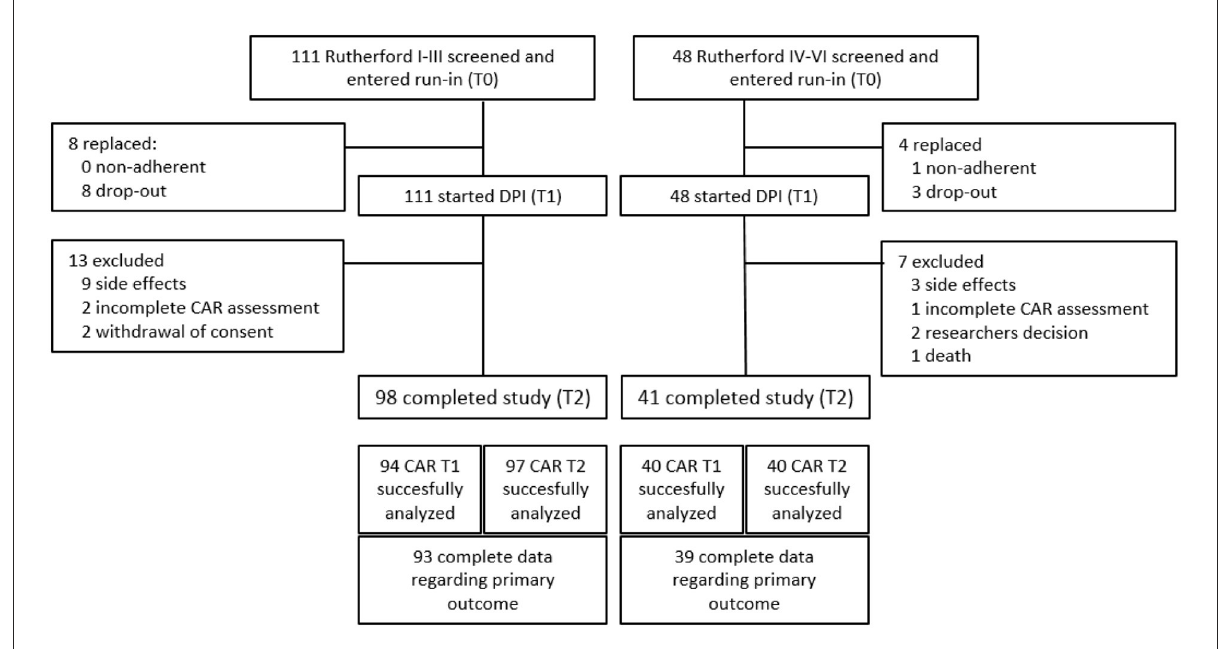
FIGURE1 Flow diagram of enrolment and